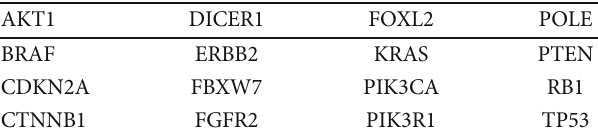
Figure 3: Positive immunohistochemistry of the tumoral cells for SATB2. Table 1: Cancer hotspot panel used by